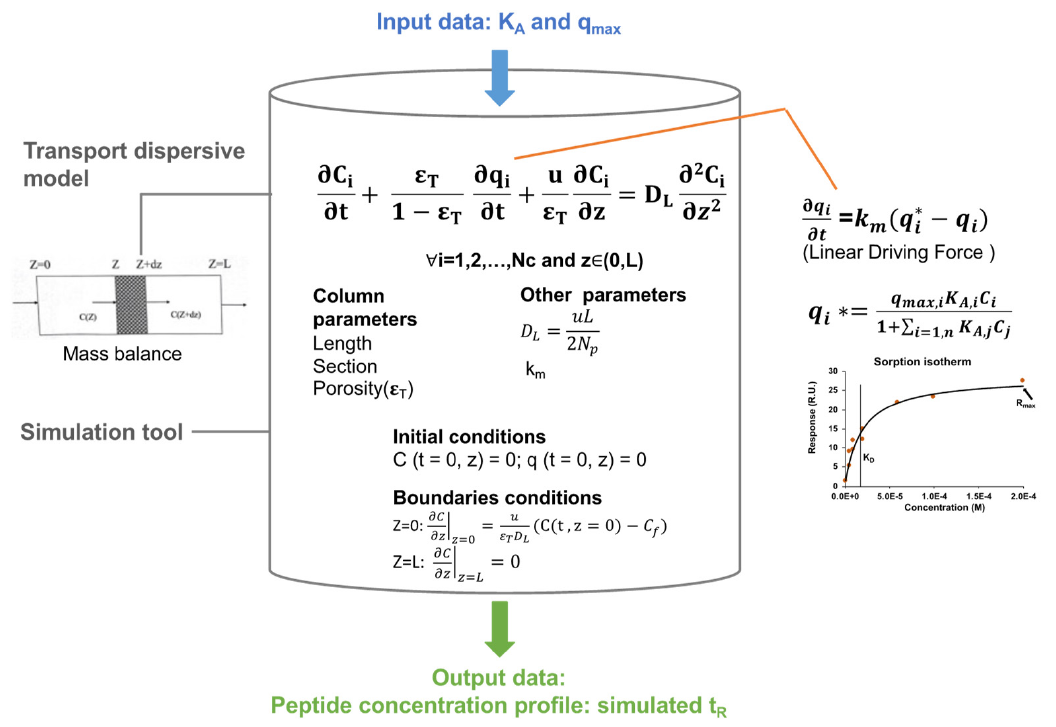
Figure 5. Chromatographic column modelling using transport dispersive model.